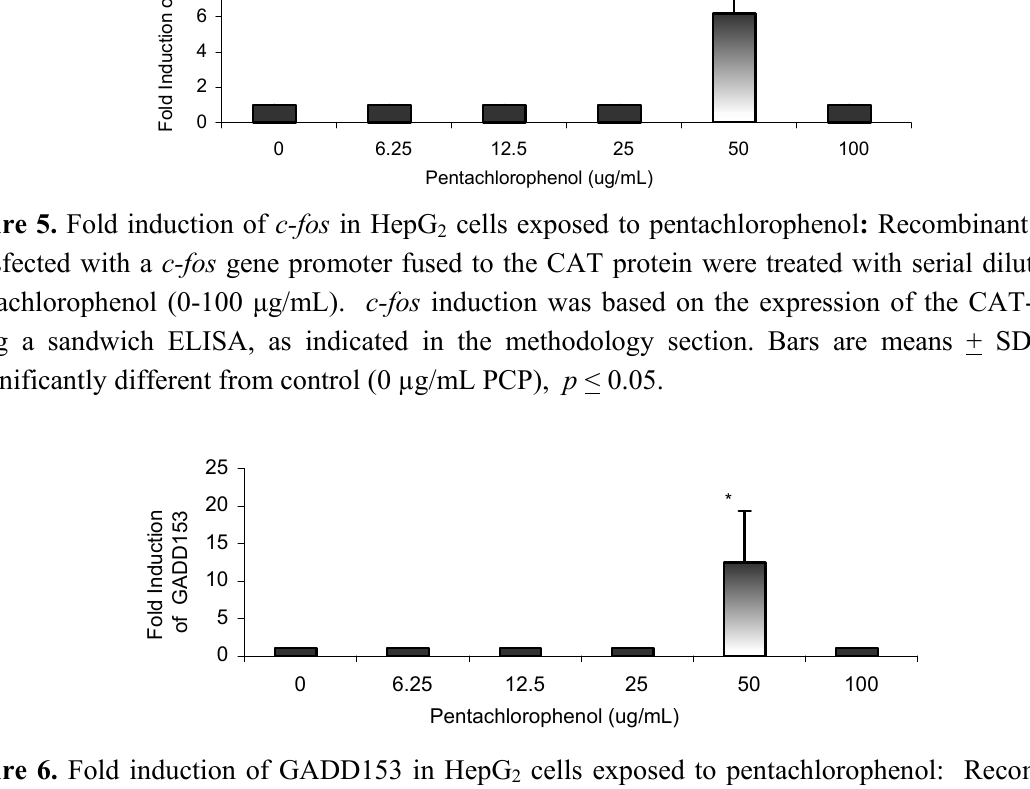
cells exposed to pentachlorophenol: Recombinant Figure 6. Fold induction of GADD153 in HepG 2 cells transfected with a GADD153 gene promoter fused to the CAT protein were treated with HepG 2 serial dilutions of pentachlorophenol (0-100 µ g/mL). means + SDs, n=3. * Significantly different from control (0 µg/mL PCP), p < 0.05.